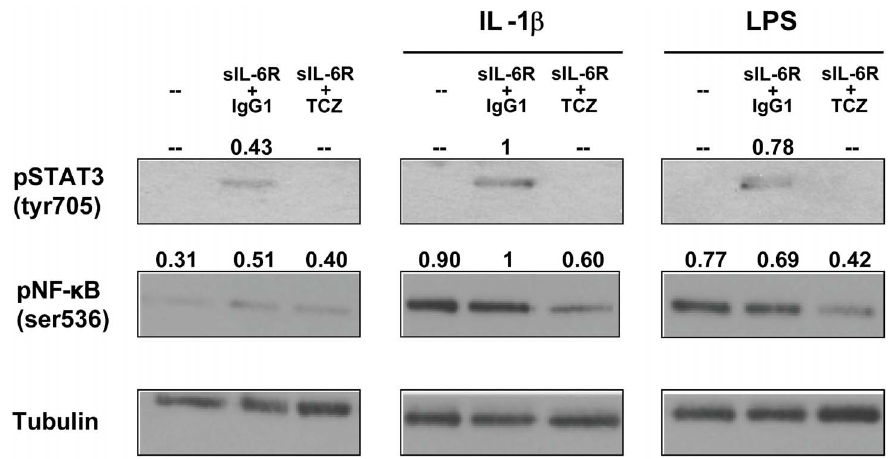
Figure 8. Western blots showing the expression of phospho–STAT3 (Tyr 705 ), phospho–NF-kB (Ser 536 ) in total lysates of RA synoviocytes pretreated as in Figure 7B for 1 hour and then stimulated with IL-1 b (1 ng/ml) or LPS (10 ng/ml) for 90 minutes. Expression of a -tubulin was used as a loading control. Results of densitometric analysis are shown above each blot. Data are representative of 3 independent experiments.